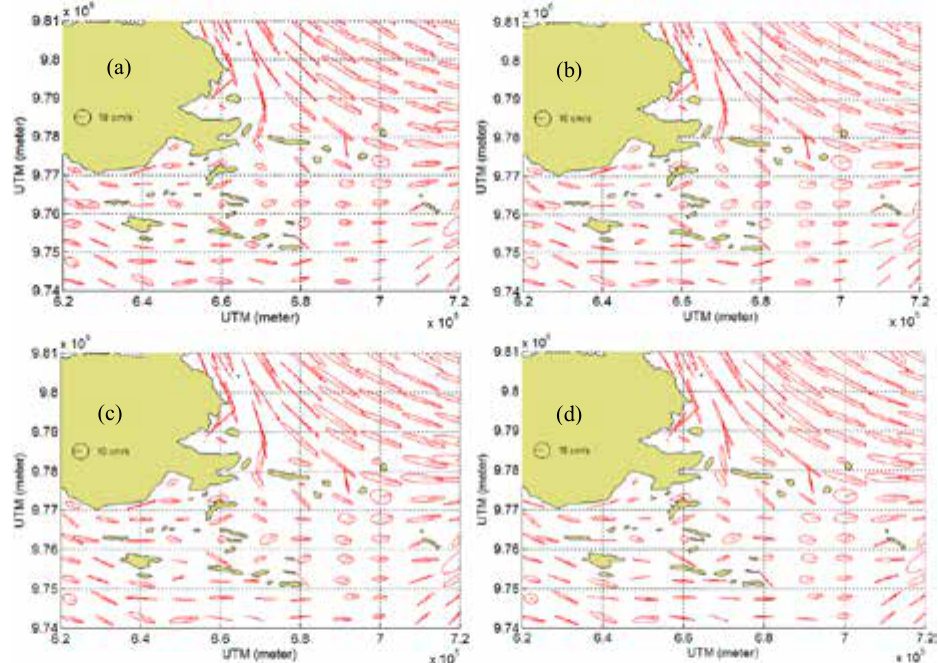
Fig. 7: The calculated K1 tidal current in layer‐1 near the bottom (a), layer‐4 of water column (b), layer‐7 of water column (c), and layer‐10 at the surface water (d)